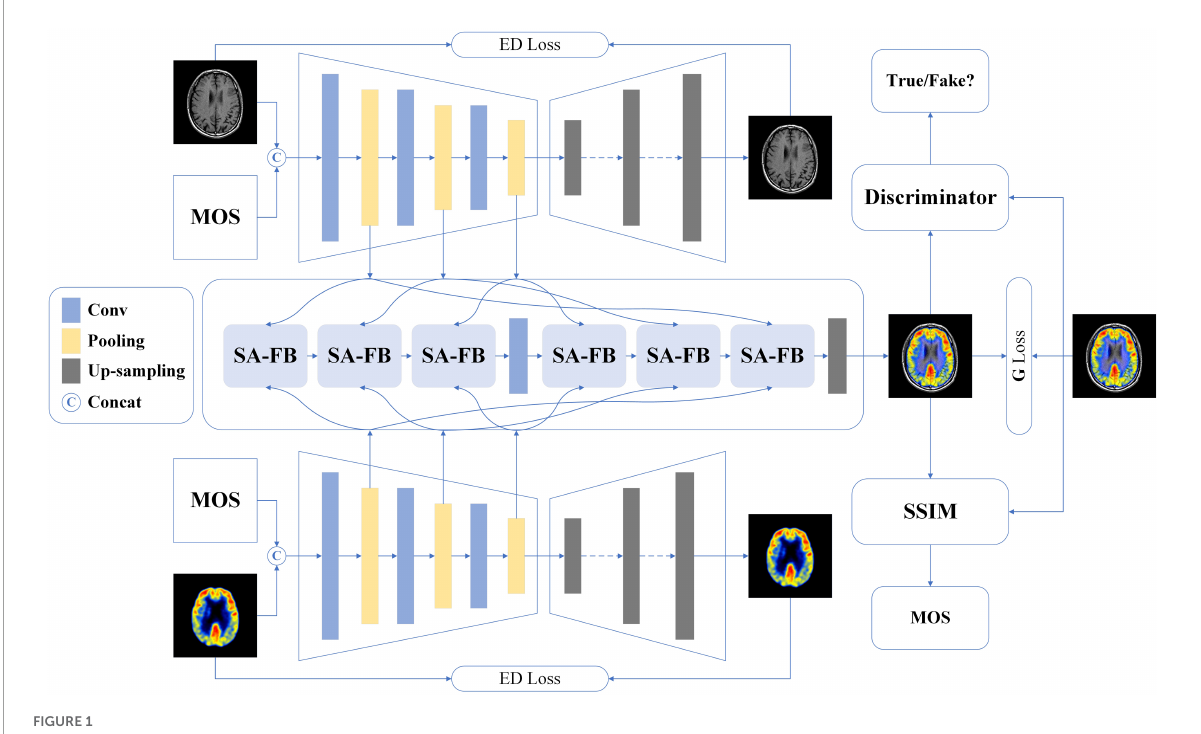
FIGURE1 The overall architecture of our proposed